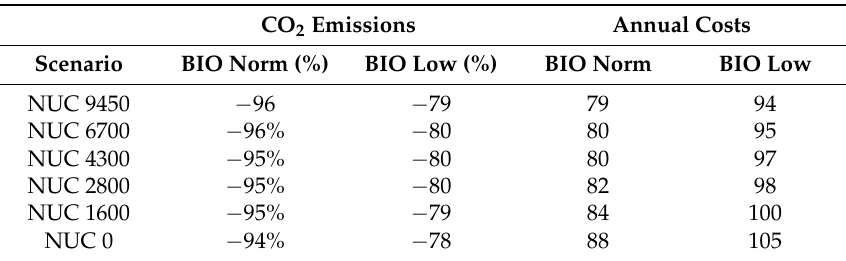
Table 3. CO 2 emissions and relative annual system costs of the national case. The CO 2 emissions are reported as the change from 1990 levels, while the annual system costs are reported with a relative scale, 100 = costs of the national reference system (Finland in